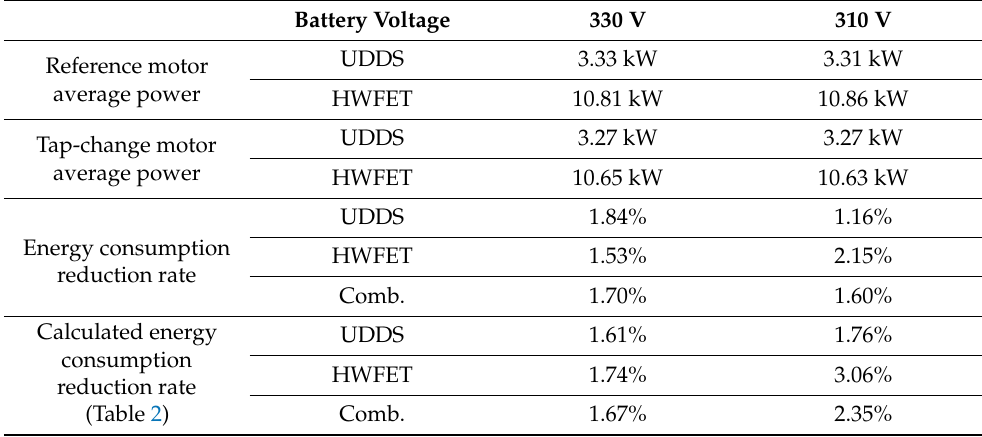
Table 3. Experimental results: energy consumption improvement